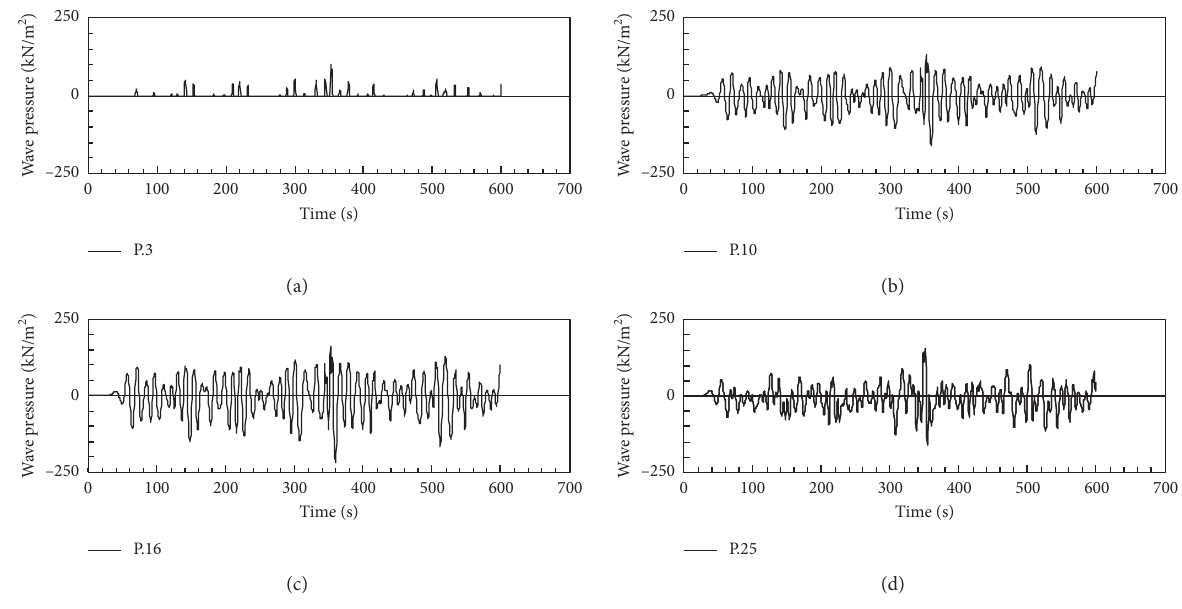
Figure 14: Time history of wave pressure on the breakwater system: (a) 3, (b) 10, (c) 16, and (d) 25 points. Table 3: Medium parameters used for the analyses by FLIP model.